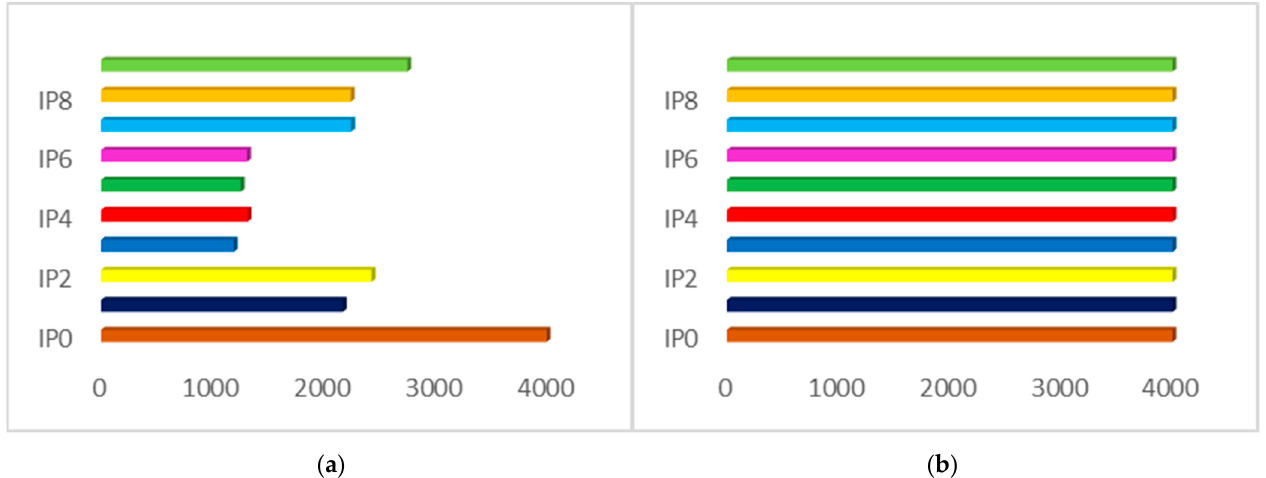
Figure 2. The number of records for each IP during the observation period ( a ) before SMOTE; ( b ) after SMOTE . ( b ) after